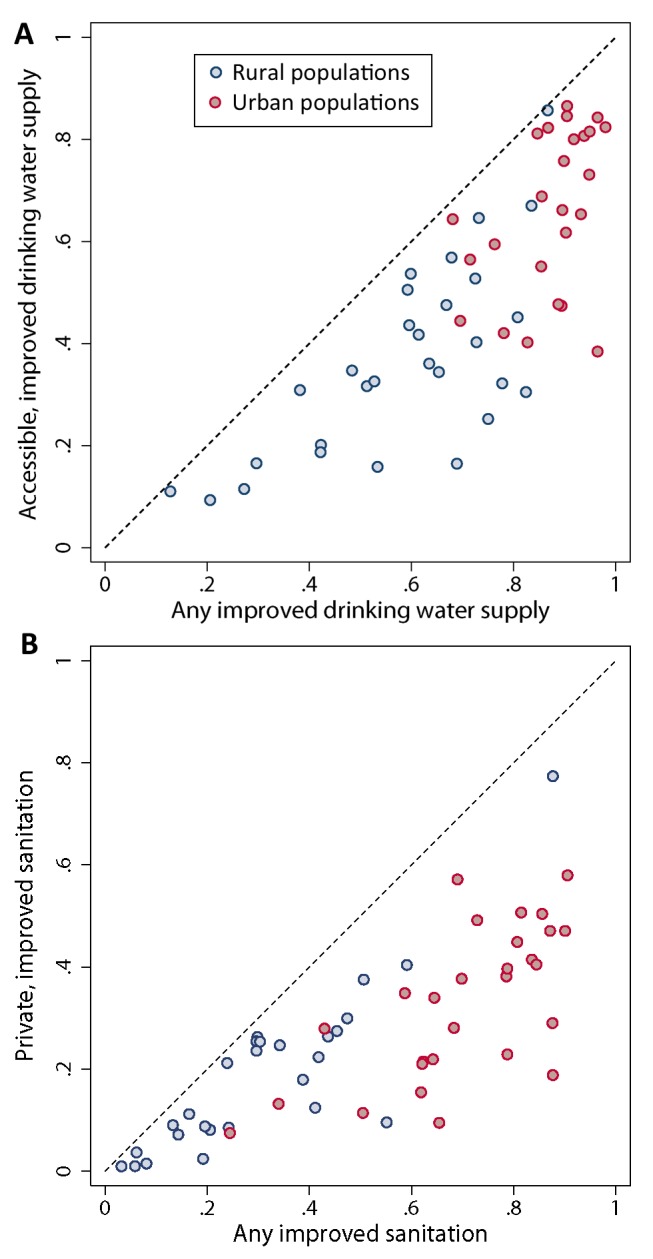
Comparison of (A) any improved drinking water source against accessible, improved drinking water source and (B) any improved sanitation against private improved sanitation.Dots show national comparisons for urban (red) and rural (blue) populations. An accessible drinking water supply is defined as one within 15 minutes of the household; private sanitation is defined as a facility used by only one household.